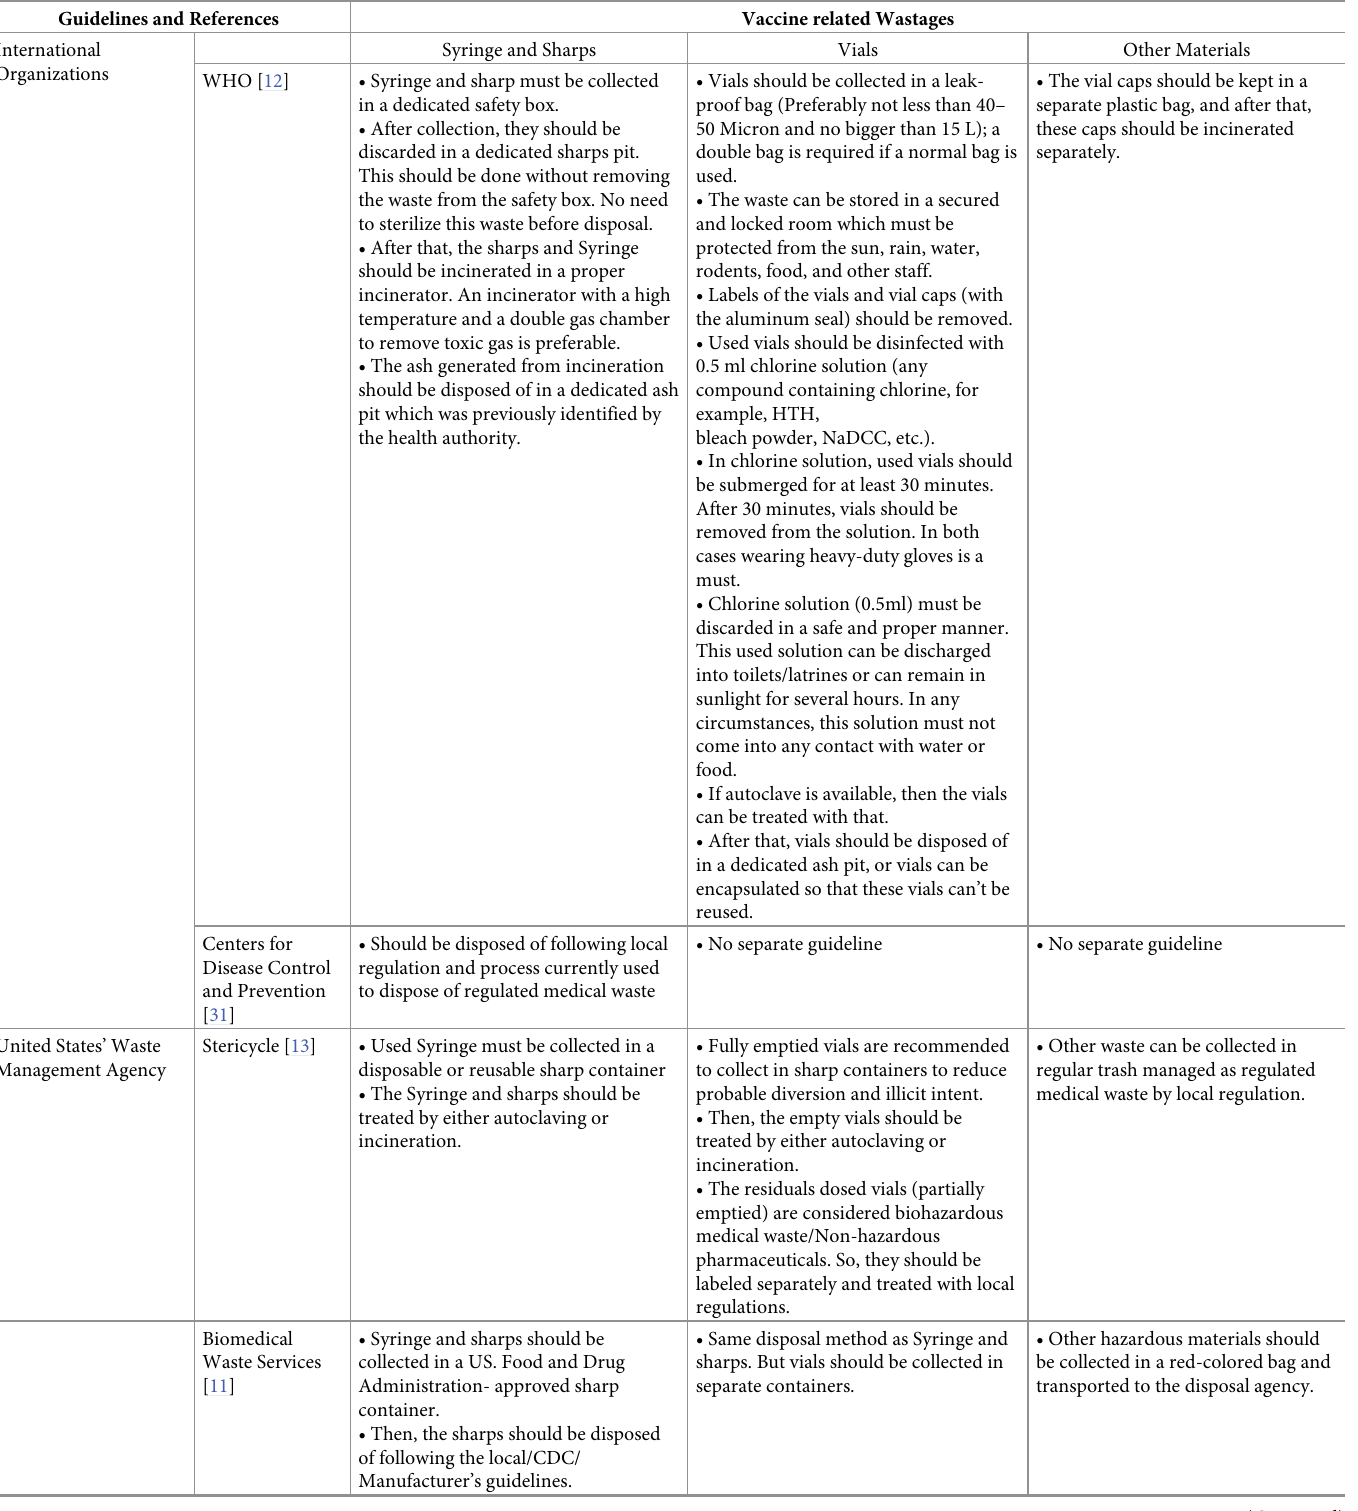
Table 2. Guidelines regarded to the treatment of the discarded COVID-19 vaccine